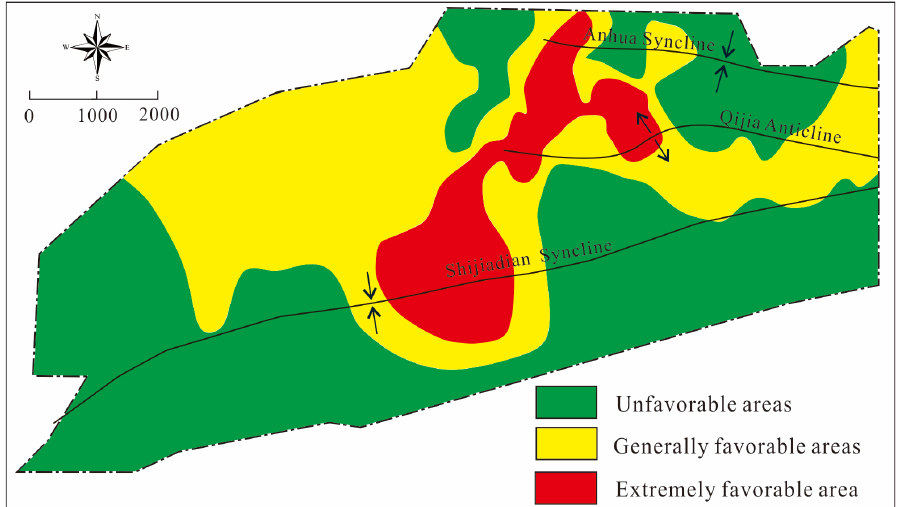
Figure 17. Prediction results of favorable areas in the study area.